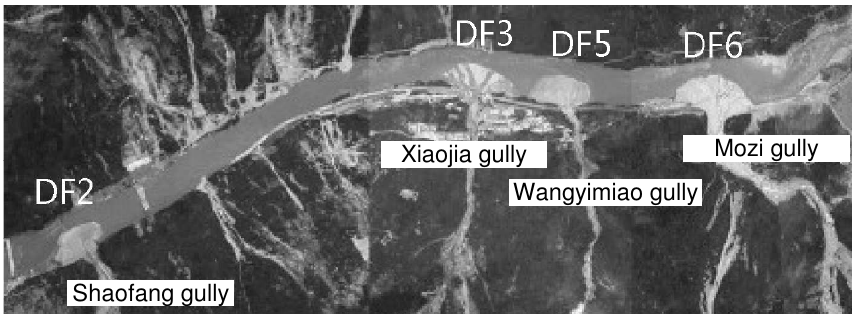
Figure 2. Aerial photo acquired on 15 August 2010 representing a series of debris flow deposits along the Minjiang, which were generated by the 14 August 2010 rainfall that hit the Sichuan province (China). Such a figure is a re-elaboration of Figure 9c presented in Tang et al. [10]. Table 1. Summary of the obstruction configuration field data determined from the areal photo reported in Tang et al. [10], depicting a series of debris dams along the Minjiang river in the Sichuan Province (China) caused by the intense alluvial event of 14 August 2010. Nomenclature follows the scientific literature [10]. The obstruction ratio r b is defined as the ratio between the maximum extension of the deposit along a direction orthogonal to the main river flow and the main river width. Test r b ( − ) DF 2 0.85 DF 3 0.63 DF 5 0.63 DF 6